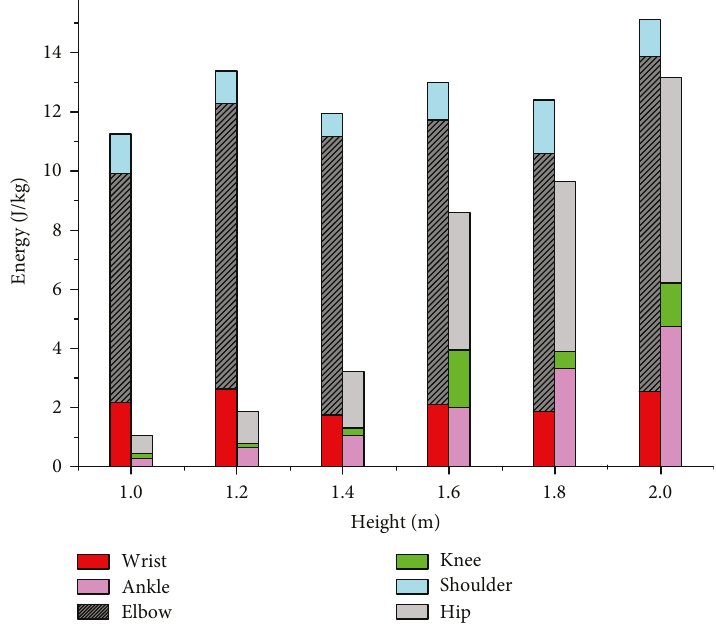
Figure 8: Mean joint work values for the wrist, elbow, shoulder, ankle, knee, and